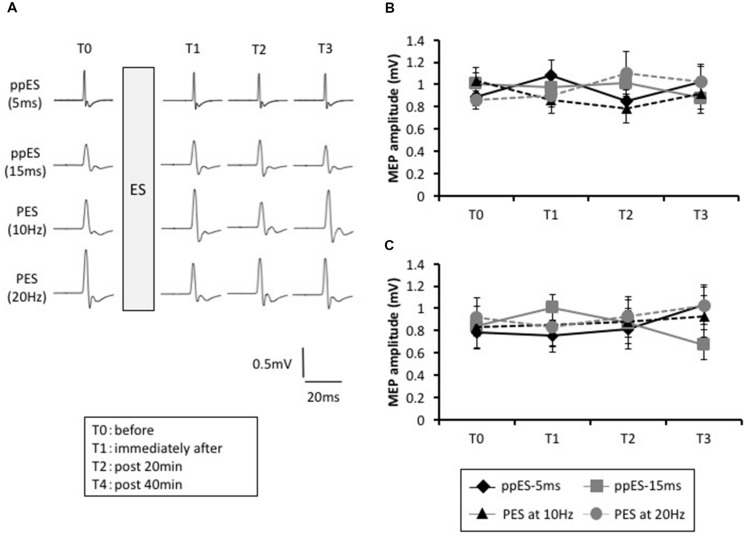
The effect of short-duration ppES and PES on the MEP recorded in the abduction digiti minimi (ADM) muscle.
(A) Typical MEP waveforms recorded in APB muscle in response to ppES, and PES at 10 Hz and 20 Hz for each time (pre, immediately, and 20 and 40 min after electrical stimulation). (B) The changes in the group mean MEP amplitude of APB muscle (n = 12) induced by each stimulus condition. There was no significant effect of stimulus condition [F(1.823,27.342) = 0.022, p = 0.972] or time [F(3,45) = 0.291, p = 0.883] on MEP amplitude. Furthermore, no significant interaction was identified between stimulus condition and time [F(4.252,63.787) = 2.274, p = 0.067]. Error bars indicate SE. (C) The changes in the group mean MEP amplitude of ADM muscle (n = 12) induced by each stimulus condition. There was no significant effect of stimulus condition [F(2.192,32.886) = 0.410, p = 0.691] or time [F(3,45) = 0.204, p = 0.893] and no interaction between stimulus condition and time [F(4.432,66.481) = 2.097, p = 0.084]. Error bars indicate SE.